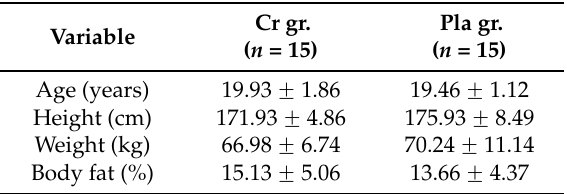
Table 1. Subject